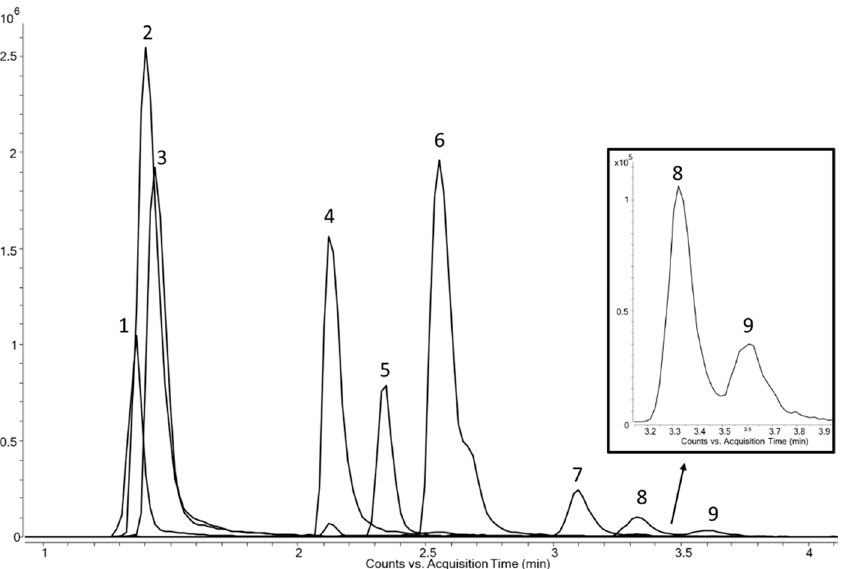
Figure 2. Extracted ion chromatogram of PA 6, PA 6.6, and PA 12. Peaks: 1 = cyclic trimer of PA 12; 2 = cyclic dimer of PA 12; 3 = cyclic monomer of PA 12; 4 = cyclic dimers of PA 6/6.6; 5 = cyclic trimer of PA 6; 6 = cyclic tetramers of PA 6/6.6; 7 = cyclic pentamer of PA 6; 8 = cyclic hexamer of PA 6.6; and 9 = cyclic hexamer of PA 6.